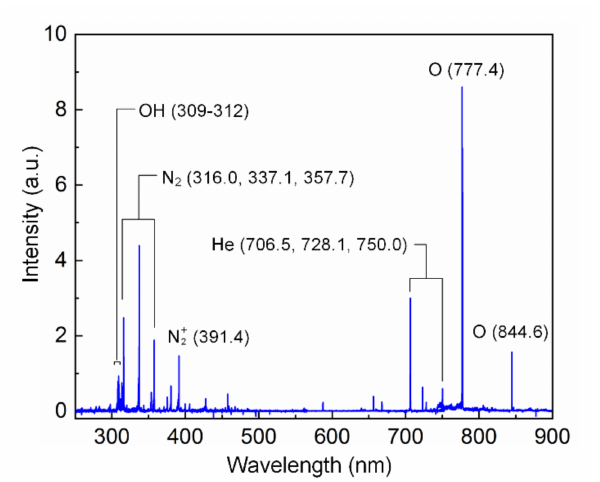
Figure 3. Emission spectrum of the helium CAP jet. The discharge parameters are: f = 23 kHz, V d = 3.5 kV, Q = 8.0 slpm, P in = 0.8